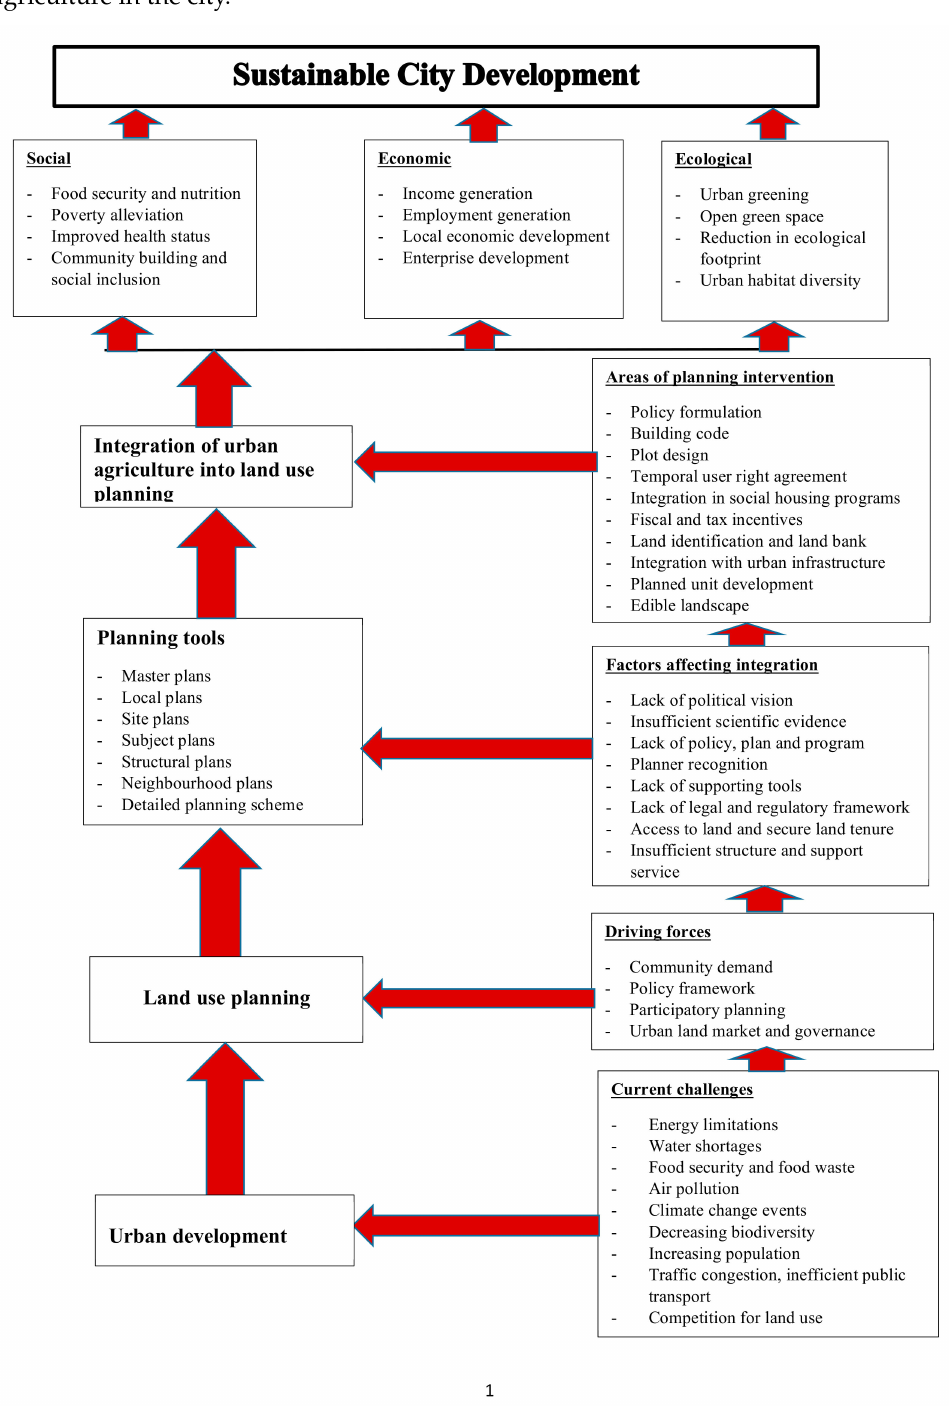
Figure 1. Conceptual framework for integrating urban agriculture into sustainable city